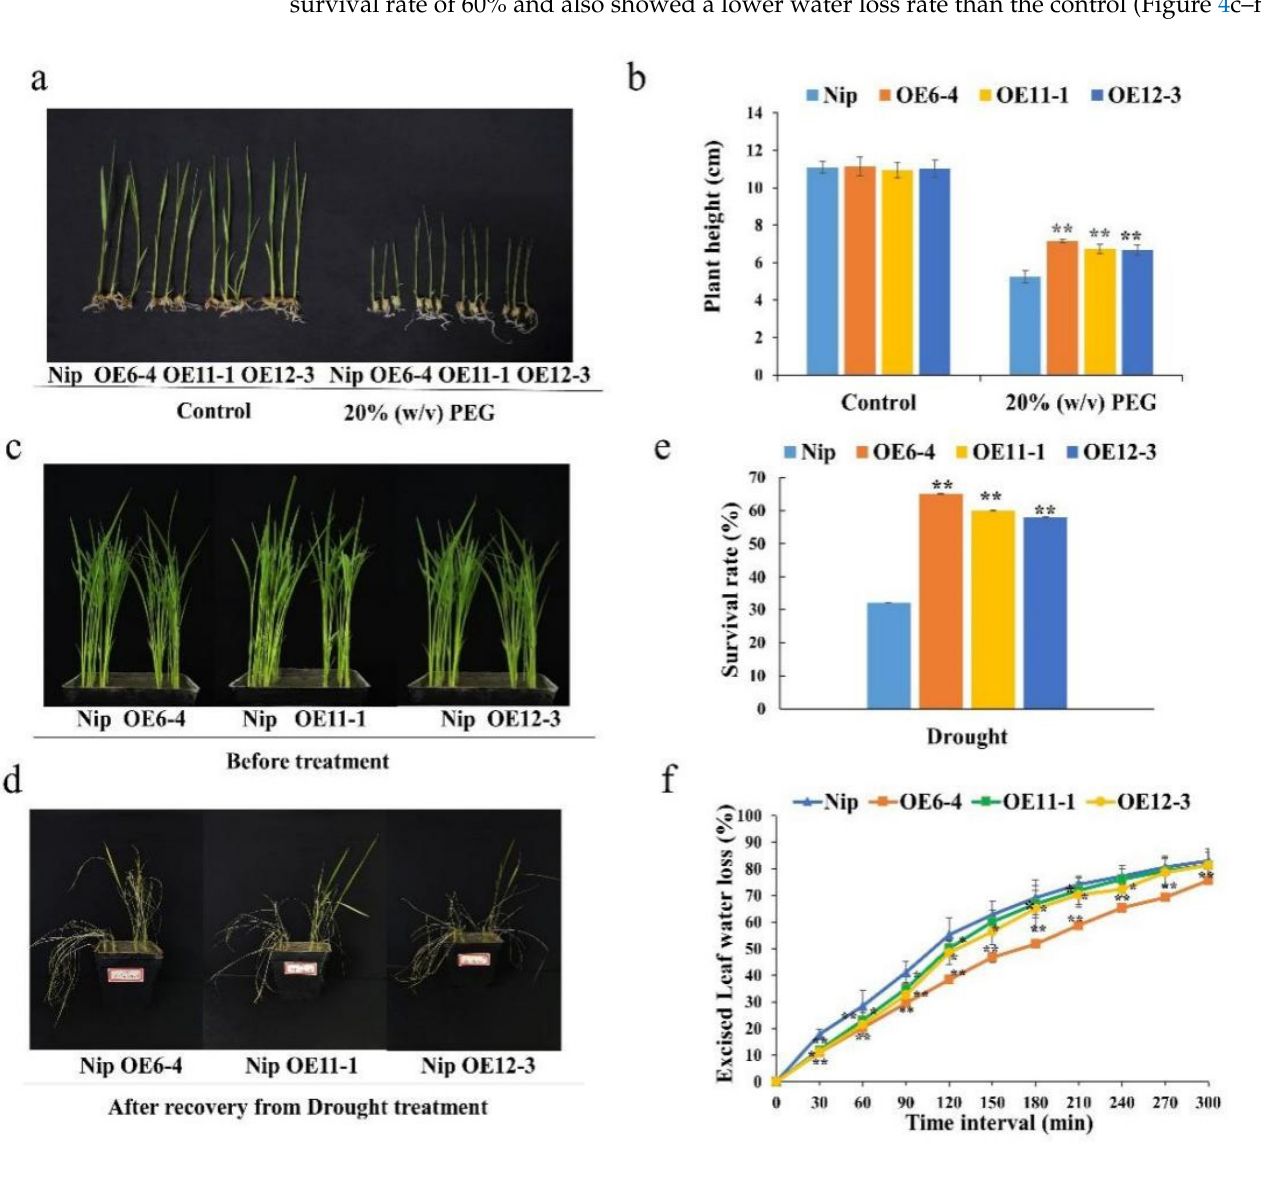
Figure 4. Drought stress treatment of OsMLP423 transgenic lines. ( a ) OsMLP423 transgenic plants grown at 20% w / v PEG for 7 days. ( b ) Relative plant heights. ( c , d ) Phenotypic differences between OsMLP423 overexpressing and wild-type plants during recovery after drought treatment. ( e ) Survival rate. ( f ) Water loss rates of detached leaves from 14-day-old plants. Values are mean ± SE ( n = 3). Asterisks indicate significant differences between transgenic lines and WT (* p < 0.05, ** p < 0.01). n = 20 plants per treatment.